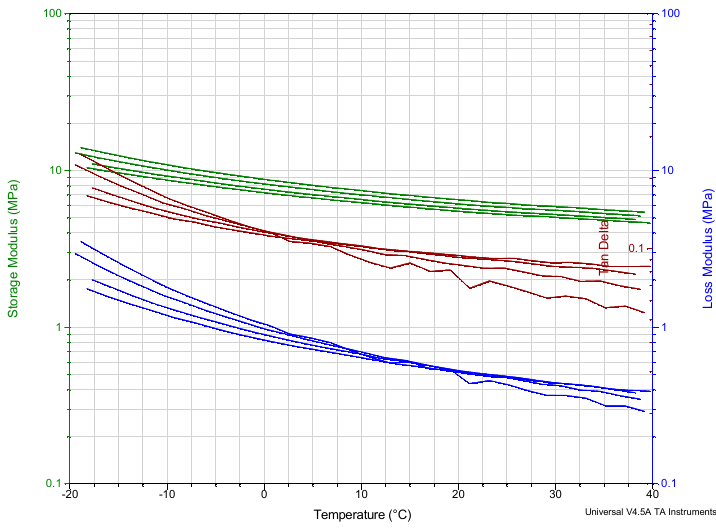
Figure 3. DMA results for all excitation frequencies in the temperature range from − 20 to 40 °C.